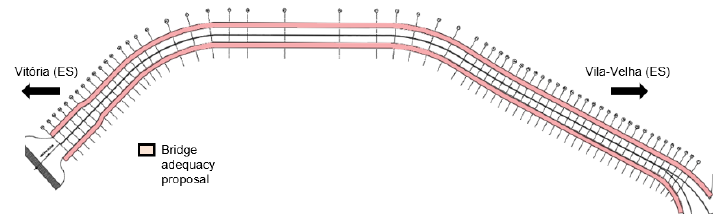
Figure 6. The highlight of hollow-core slabs